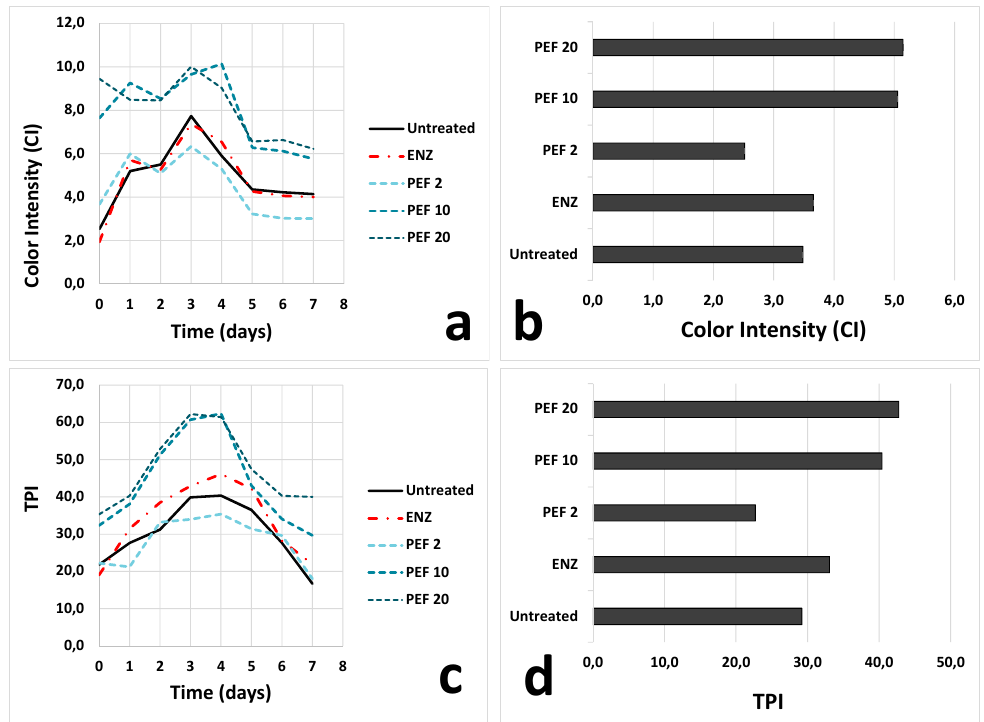
Figure 1. Trends measured for color intensity ( a,b ) and total phenolic index (TPI) ( c,d ) in the samples analyzed during skin maceration up to draining/pressing (day 7) ( a,c ) and at the end of alcoholic fermentation (day 9) ( b,d ). Untreated: control, no treatment; ENZ: pectolytic enzymes (20 mg kg − 1 ); PEF 2: PEF treatment, 2 kJ kg − 1 ; PEF 10: PEF treatment, 10 kJ kg − 1 ; PEF 20: PEF treatment, 20 kJ kg − 1 .